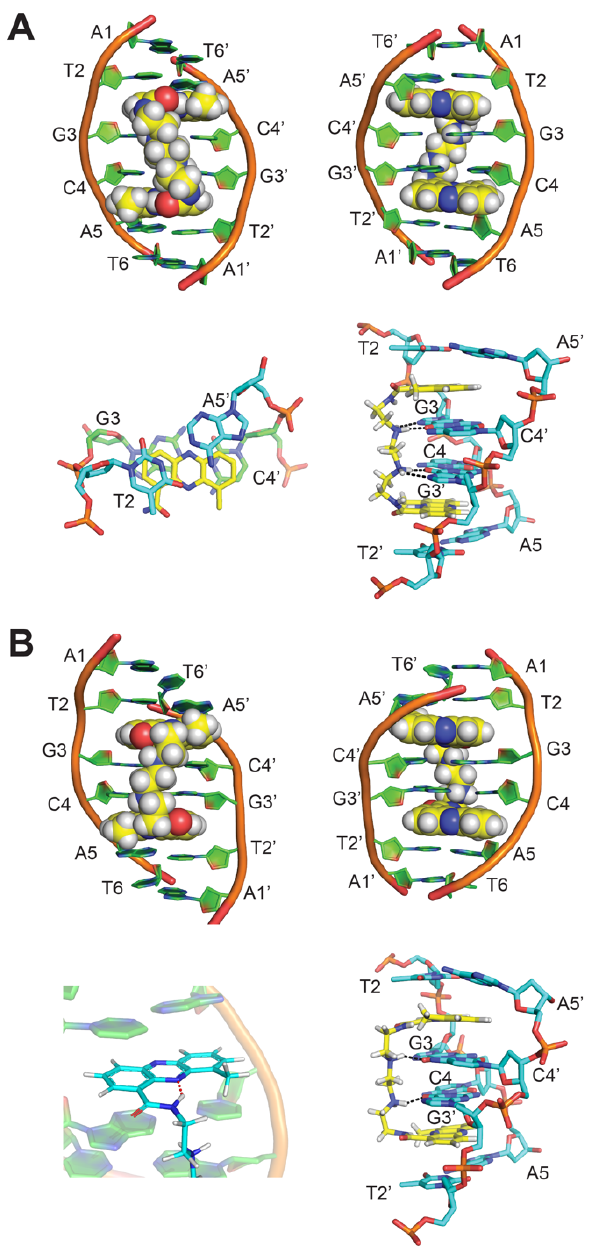
Figure 4. ( A ) NMR solution structure of the 1:1 complex of XR5944 to palindromic d(ATGCAT) 2 [PDB: 1X95]: (top) the complex structure as viewed from major groove (left) and minor groove (right). (bottom left) Intercalation mode of XR5944 phenazine chromophore (yellow) at the 5 ′ -TpG sites. Carbon atoms of DNA bases enveloped by bis-intercalation are colored green. Carbon atoms of DNA bases external to bis-intercalation are colored cyan. (bottom right) Major groove hydrogen bond interactions of the linker shown in black dashes. ( B) Updated NMR solution structure of 1:1 complex of XR5944 to d(ATGCAT) 2 [PDB: 4BZT]. (top) The complex structure as viewed from major groove (left) and minor groove (right). (bottom left) XR5944 intramolecular hydrogen bond formed between N10 and carboxamide N-H. (bottom right) Major groove hydrogen bond interactions of the linker shown in black dashes.